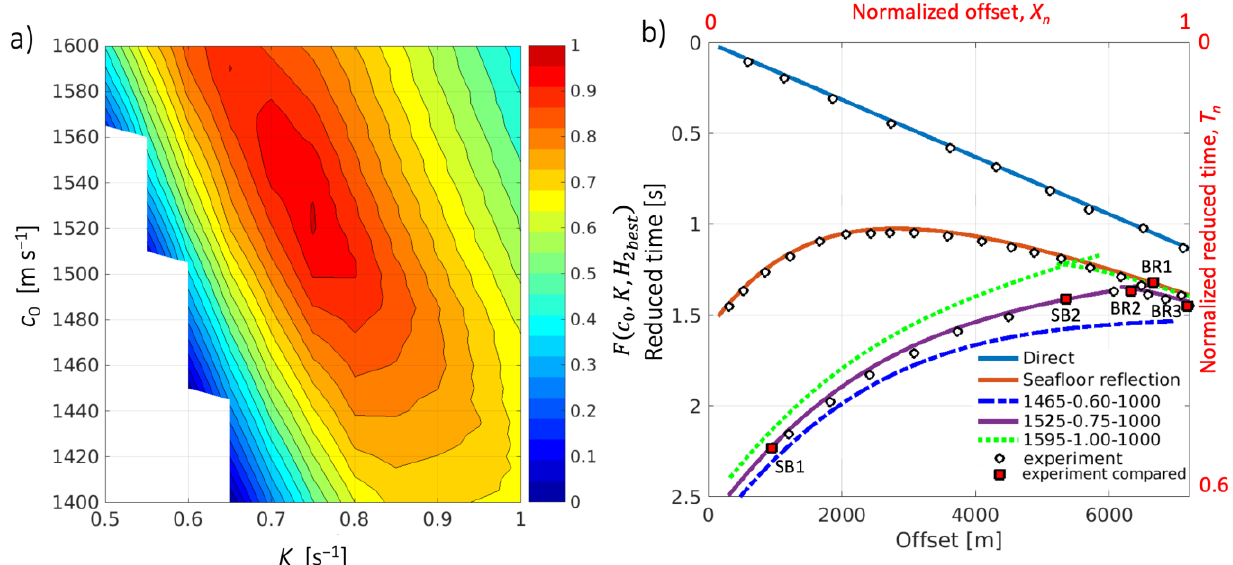
Figure 7. ( a ) The normalized weight function F norm vs. varying c 0 and K with H 2 best = 1000 m. The white area represents arrival of the bending refracted rays beyond the bounds of the HLA used. The weight function has a single prominent maximum at c 0 = 1525 m s − 1 and K = 0.75 s − 1 . ( b ) The arrival times simulated for three combinations of c 0 , K , and H 2 ( bottom right ) , overlaid with the experimentally chosen arrival times from source gather #2290. The reduction sound speed is 2000 m s − 1 . When c 0 and K are low (blue dashed line), the bending refraction is not observed within the offset range used. Normalized offset X n and normalized reduced time T n were used for calculations in Equation (5).